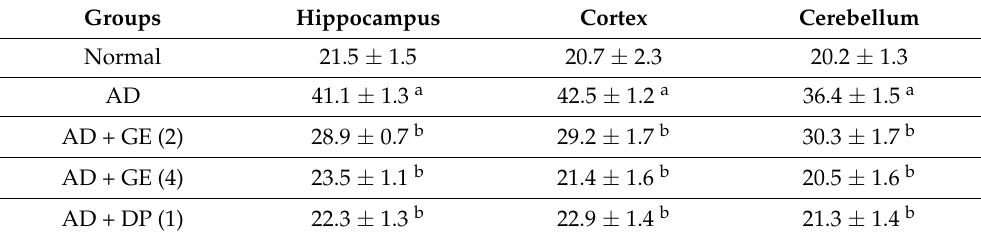
Table 1. Effect of GE on the changes in AChE levels in brain tissue biomarkers.